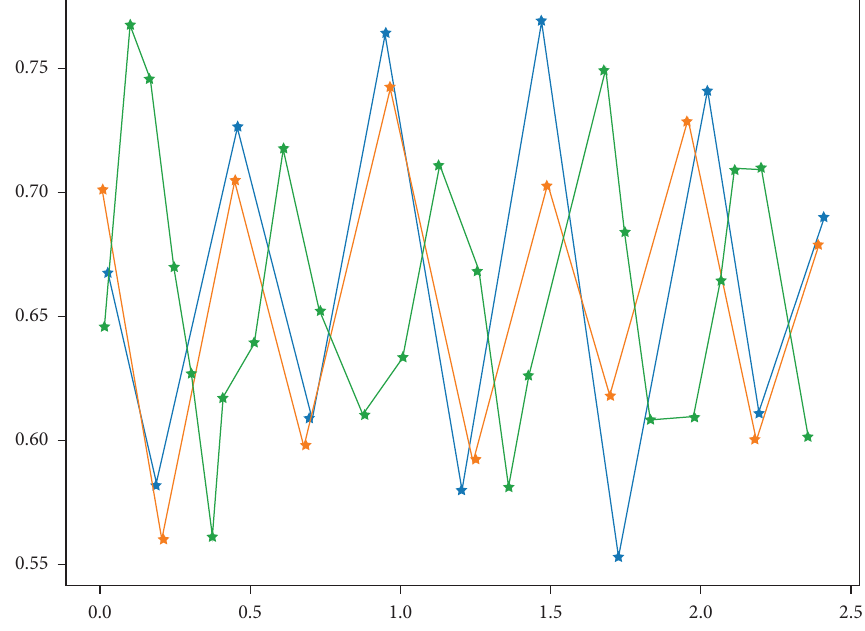
Figure 17: Inductor and output voltage current